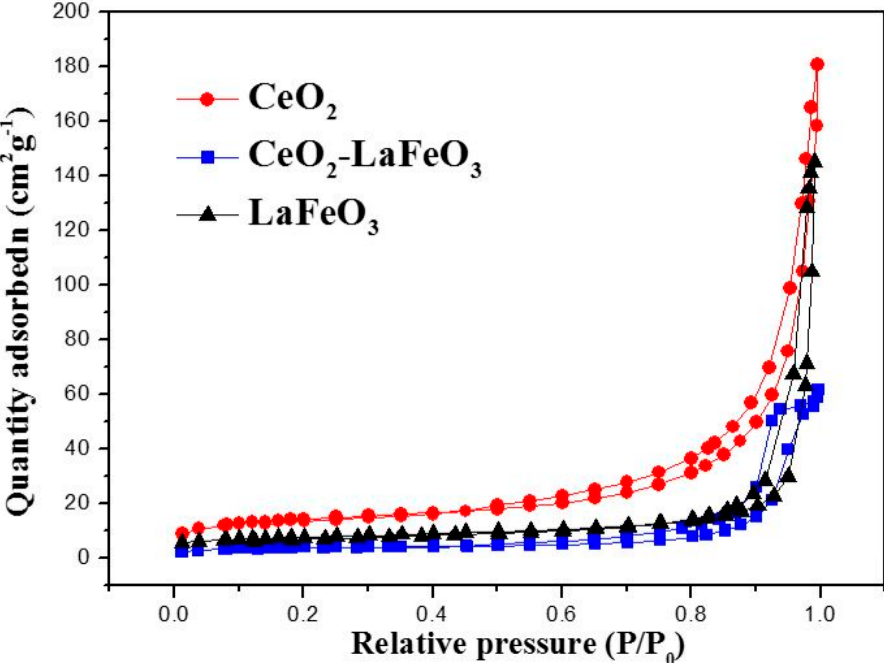
Figure 4. N 2 adsorption and desorption isotherms of LaFeO 3 , CeO 2 and CeO 2 -LaFeO 3 composite.